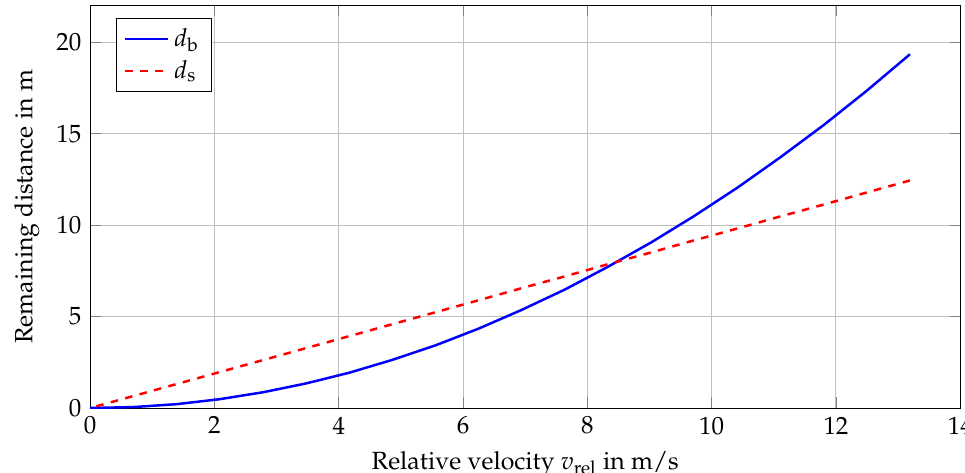
Figure 2. Remaining distance of an ego vehicle to a target vehicle for avoiding a rear-end collision in longitudinal traffic for a pure braking maneuver and a pure steering